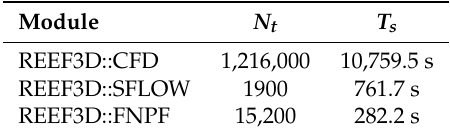
Table 5. Comparison of total number of cells N t and simulation time T s in seconds for the simulation of wave propagation over a submerged bar using the three